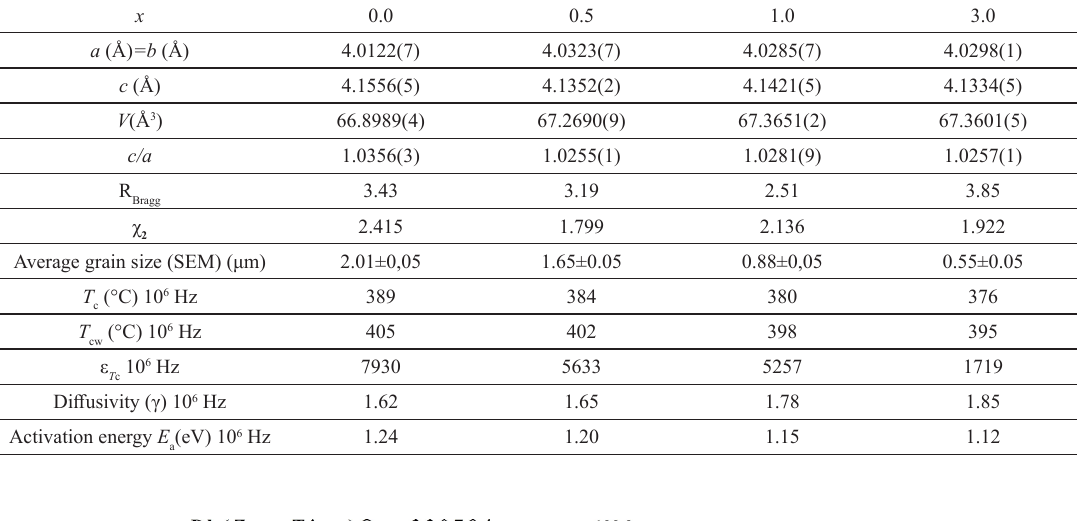
Ti ) Er O ceramics. 0.52 0.48 1- x x 3- x /2